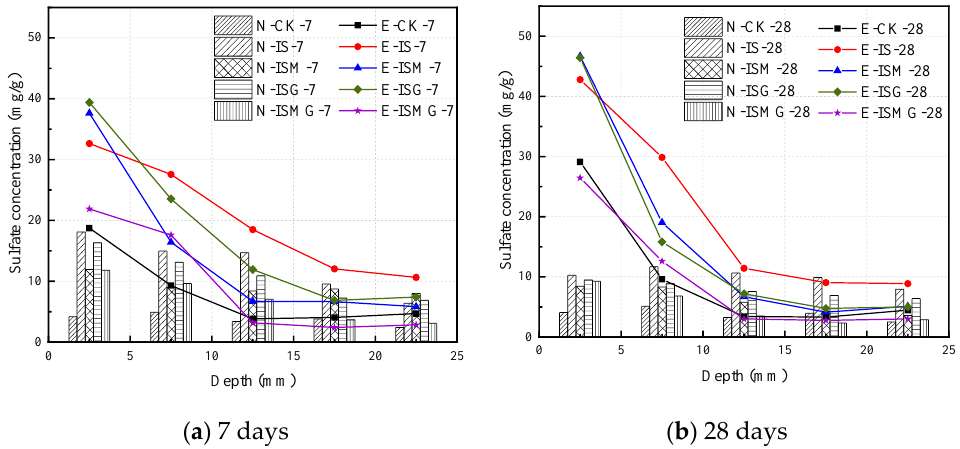
Figure 6. The sulfate concentration for specimens immersed in sulfate solution and distilled water at 7 days and 28 days, respectively.